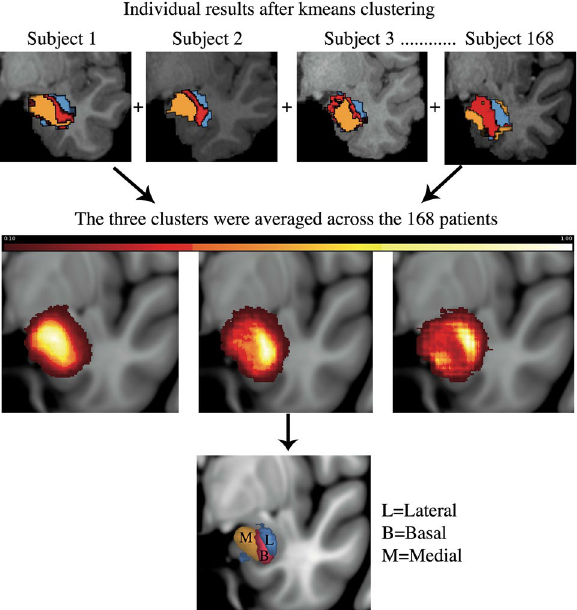
the amygdala (centromedial, basal, and lateral nuclear groups) 10,31,32 . Third, the connectivity-based clusters of all subjects were normalized to the standard MNI-152 space using linear registration with FLIRT followed by non-linear registration with FNIRT. The clusters were then separated and summed across all subjects to create common cluster maps. In this fashion, each voxel value in the final common cluster represented the number of subjects with the cluster in that location (Fig. 2). These common cluster maps were finally thresholded at 50% to